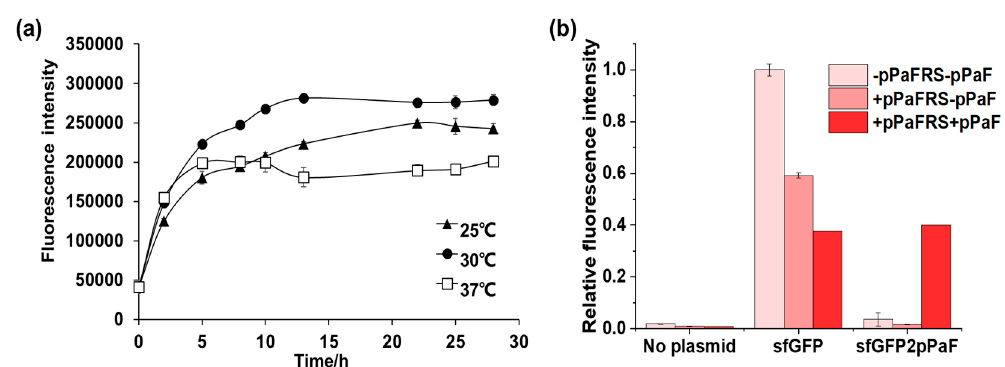
Figure 3. ( a ) Time course of sfGFP2 p PaF synthesis catalyzed by purified OTS. Two independent batch CFPS reactions (n = 2) were performed at 25 °C, 30 °C and 37 °C for each point over 24 h. ( b ). Synthesis of sfGFP2 p PaF at 30 °C for 16 h.